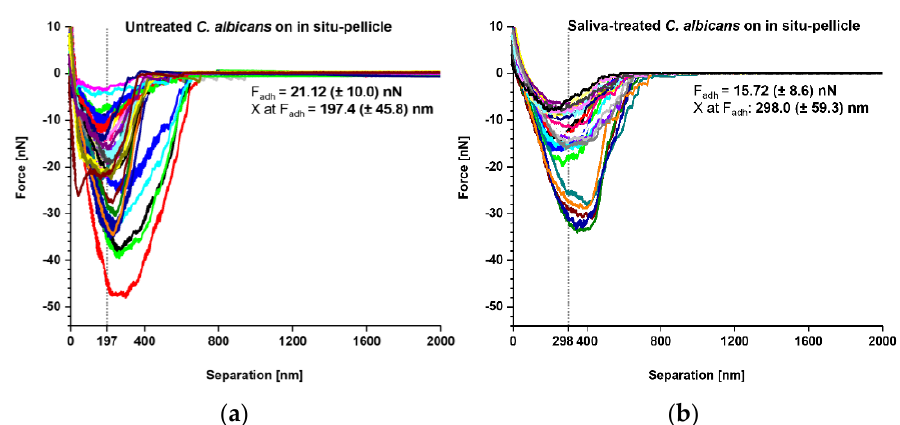
Figure 5. Comparison of adhesion forces between untreated and saliva-treated Candida albicans yeast cells on in situ pellicles of tooth enamel. Overlay of retraction curves on in situ-formed pellicles on tooth enamel. ( a ) Data for untreated C. albicans yeast cells ( n = 35) and ( b ) for saliva-treated C. albicans yeast cells ( n = 25). In each panel the mean adhesion force (F adh ) and the mean separation length of the adhesion force (X at F adh ) are given.